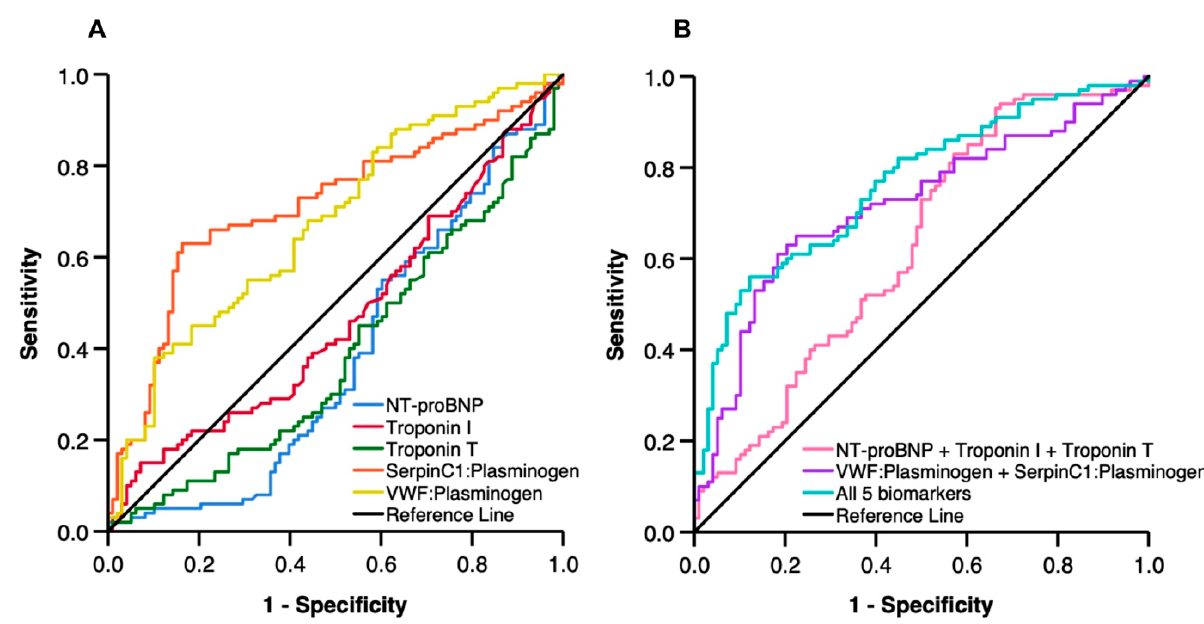
Figure 3. Receiver operating characteristic (ROC) analysis for identifying post-AMI patients with reverse LV remodeling at 1 month post-AMI. ( A ) ROC analysis for individual cardiac injury markers and coagulation/fibrinolysis protein ratios at 1 month post-AMI. ( B ) ROC analysis for combination of the LDL-EV protein ratios and three cardiac injury markers at 1 month